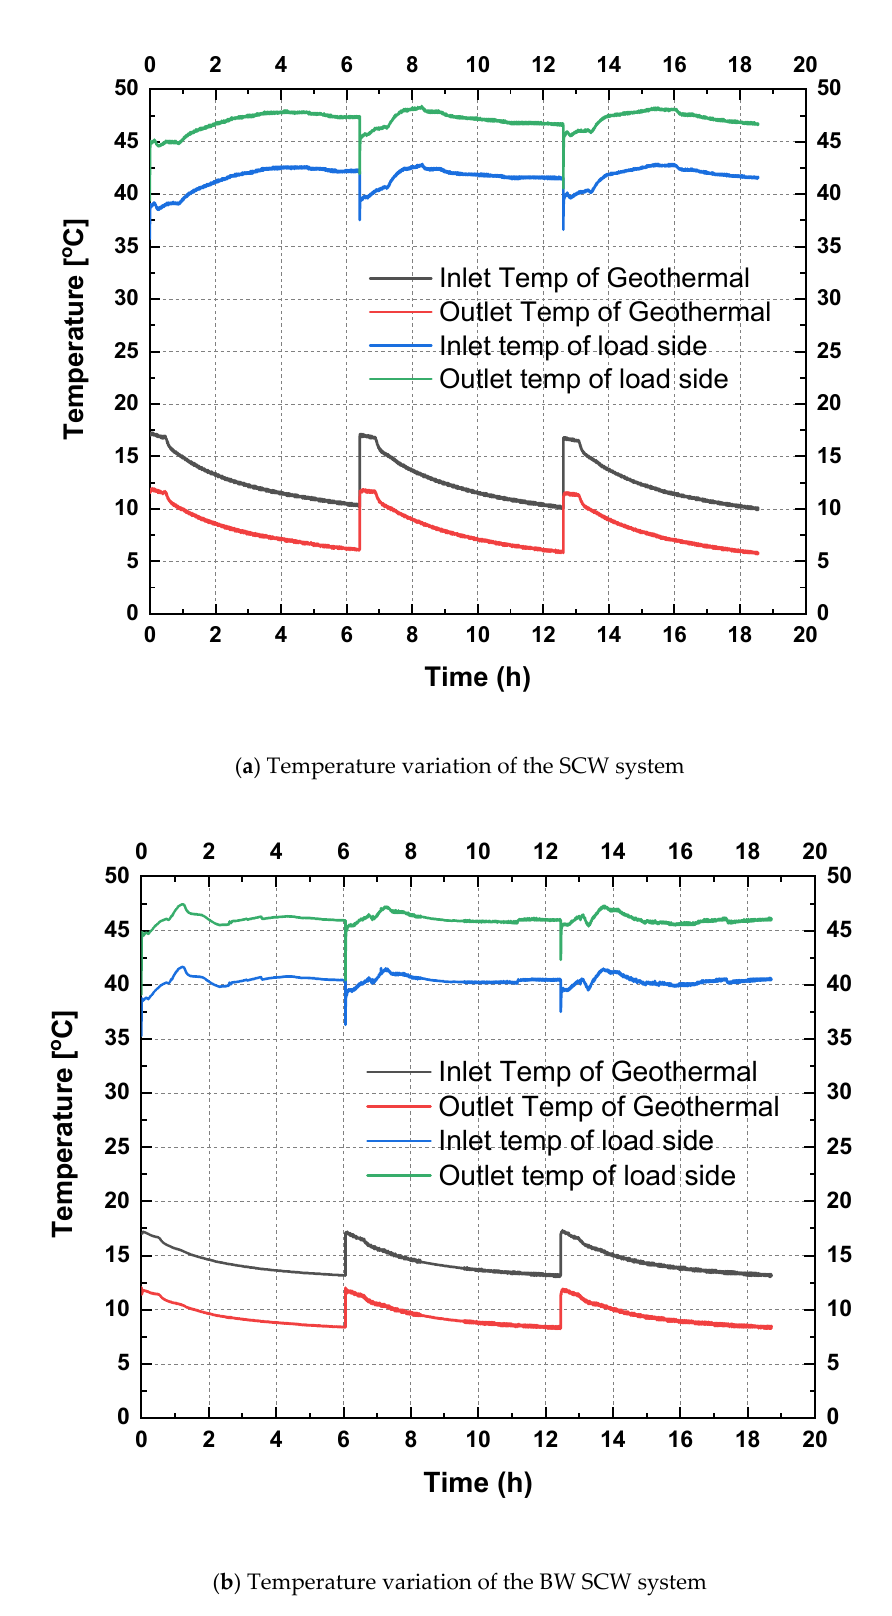
Figure 5. Temperature variation characteristics of the SCW and BW cross-mixing ground heat exchanger system during heating operation.